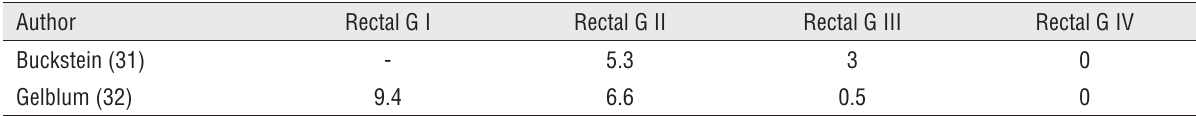
Table 8 - Rectal toxicity after brachytherapy published by Buckstein and Daphna. No high grade toxicity (grade IV) was reported. Most of the patients did not have any rectal toxicity. If toxicity was present, the peek was seen at 8 months, all resolved in 3.5